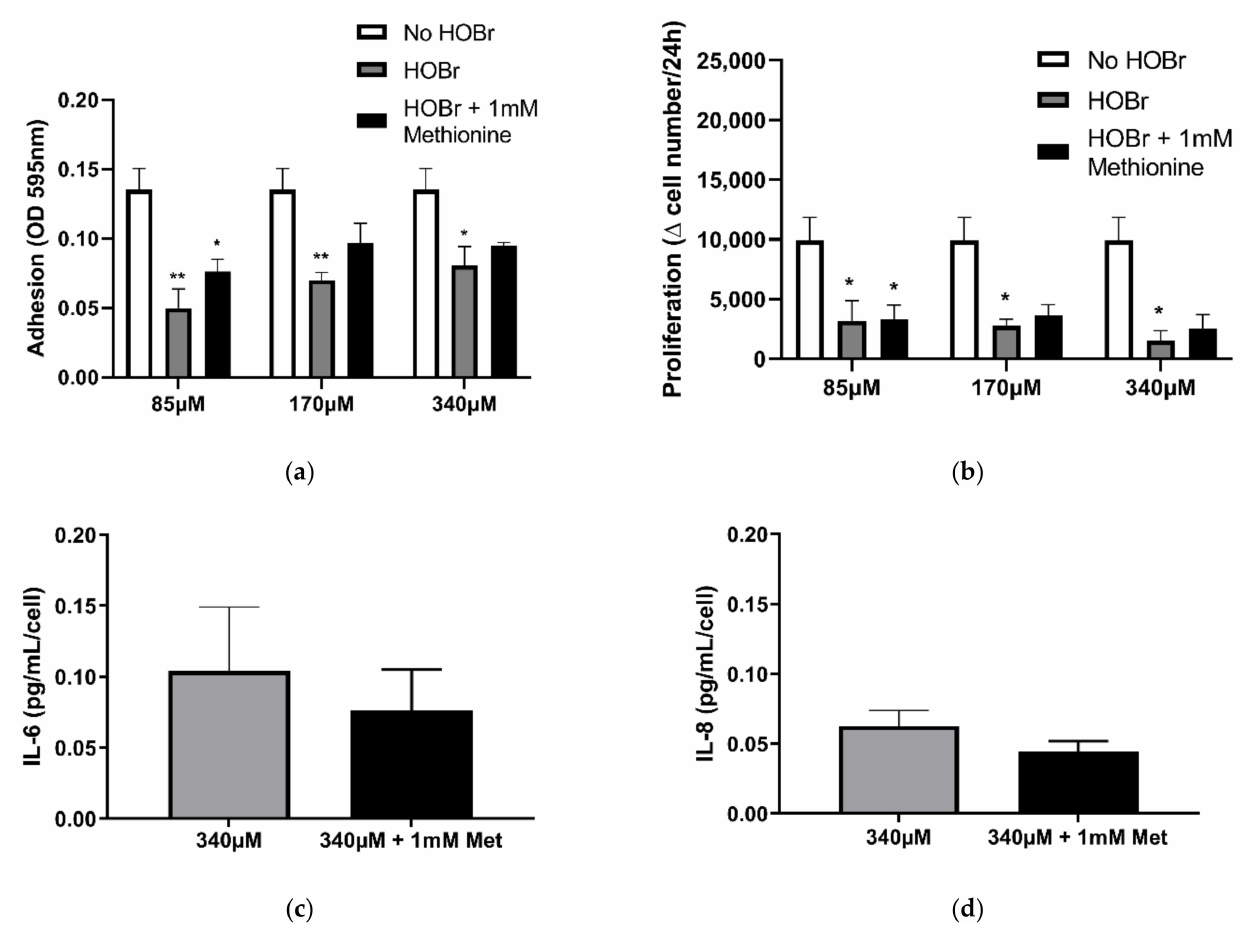
Figure 8. Comparison of the effects of bromamine quenched against HOBr-induced oxidation of BEAS-2B-derived ECM on fibroblast function. BEAS-2B-derived ECM was oxidised with (or without) HOBr concentrations of 85 µ M, 170 µ M, and 340 µ M and then incubated for 10 min with or without methionine (1 mM) to quench chloramine, followed by seeding with PHLF. ( a ) Attachment was assessed by Coomassie brilliant blue staining. ( b ) Manual cell counts at 24 h. Results are averages of the ∆ (changes) in cell number per 24 h and expressed as mean ± SEM. IL-6 ( c ) and IL-8 ( d ) release measured by ELISA. Results were obtained as picograms per microlitre per cell (normalised against the cell counts at 24 h post-seeding) and are expressed as mean ± SEM. ( a , b ) n = 5. ** p < 0.01, * p < 0.05, significance was compared against No HOBr; two-way ANOVA with Tukey’s multiple comparison test was performed. ( c , d ) n = 5. * p < 0.05, significance was compared against 340 µ M HOBr; 2-tailed paired Student t test was